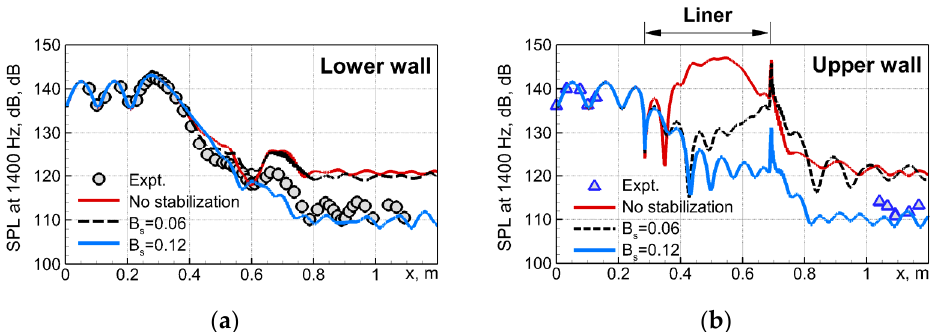
Figure 26. Effect of stabilization (10) and its amplitude parameter B s on distributions of SPL along